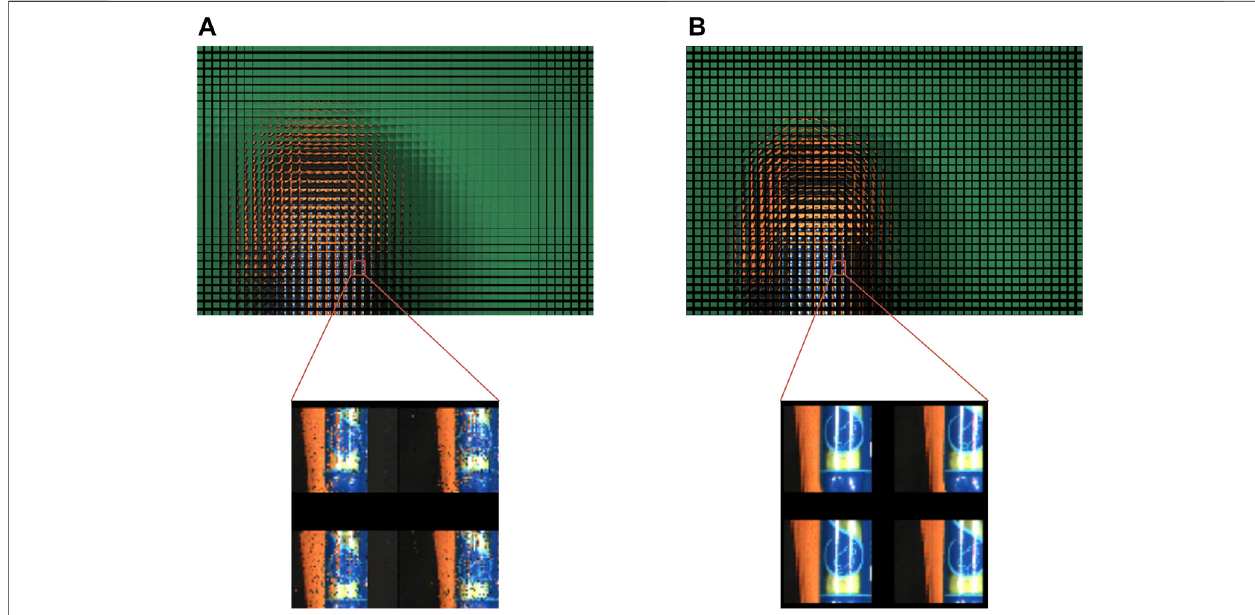
FIGURE 12 | Overall and partial magni fi cation effects: (A) SPOC algorithm and (B) average SPOC algorithm.